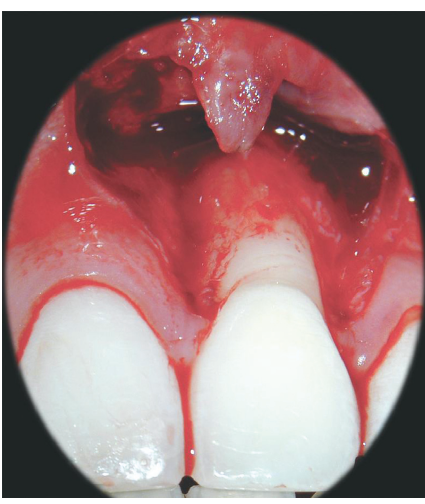
Figure 3: After the dissection of the scar tissues that limited the mobility of the flap, it can be repositioned coronally without tensions.